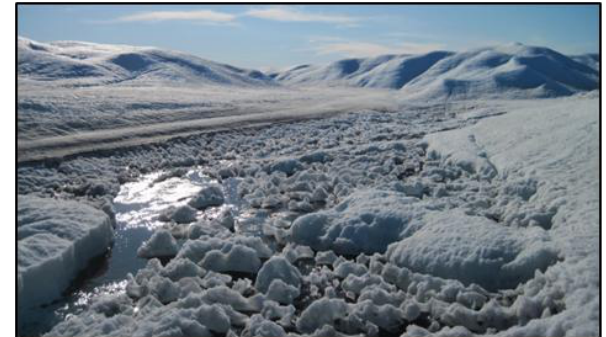
Figure 2. The ice sheet surface at 67.0 ◦ N, 50.0 ◦ W, 580m (7km from the margin), early in the melt season (10 June 2011). The foreground is a recently drained pond with cryoconite debris and “spikes” of clean ice that have melted much more slowly due to their higher albedo. The “hills” in the background have heights of 3–5m and very low debris